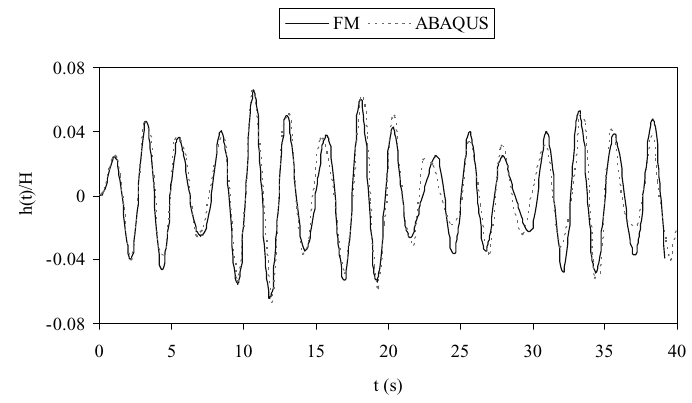
Fig. 8. Dynamic response h ( t ) of a three-span cable ( f = 0.4H z ,q 0 = 0.01 H / l )